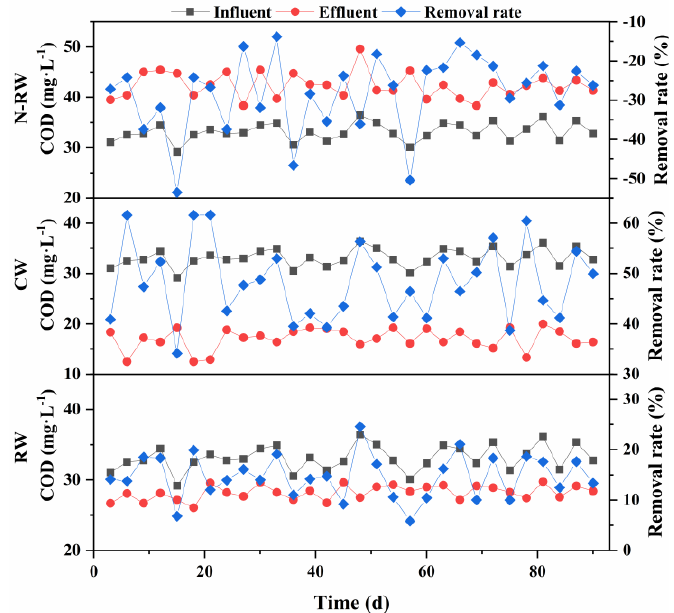
Figure 5. Changes of COD concentration and corresponding removal rate in influent and effluent of three groups of wetland systems.